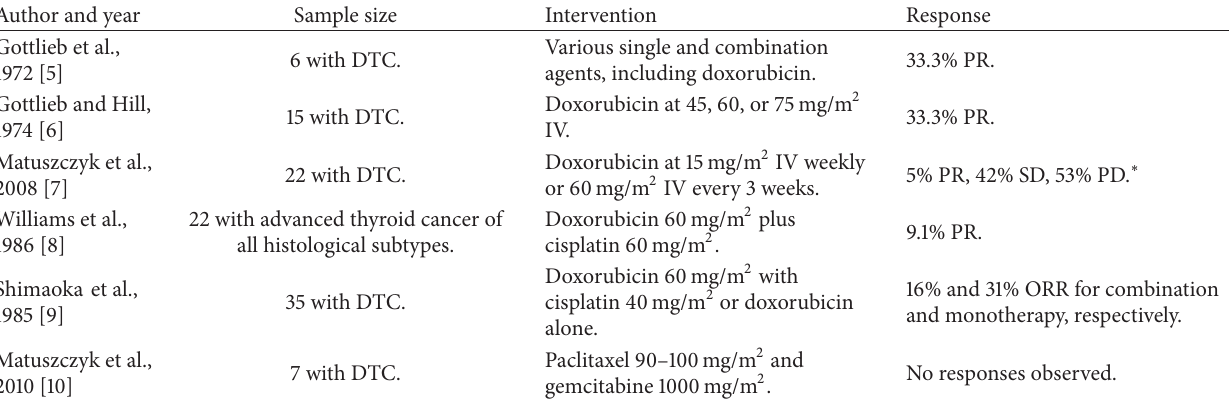
Table 1: Select studies of chemotherapy in metastatic differentiated thyroid